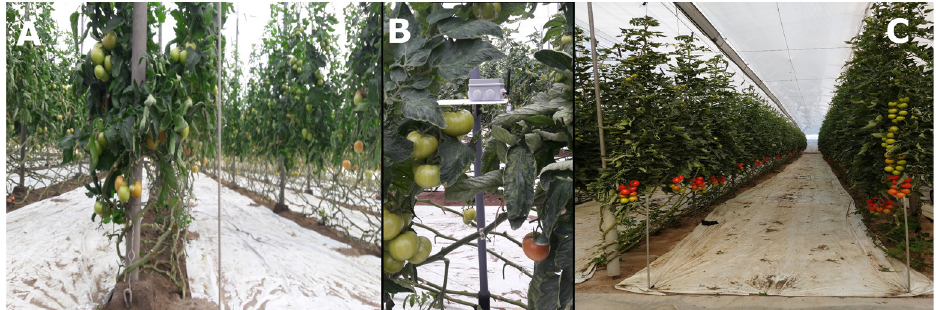
Figure 3. ( A ) Tomato crop side profile. ( B ) Location of transmitter node inside the greenhouse. ( C ) View of greenhouse passageway.